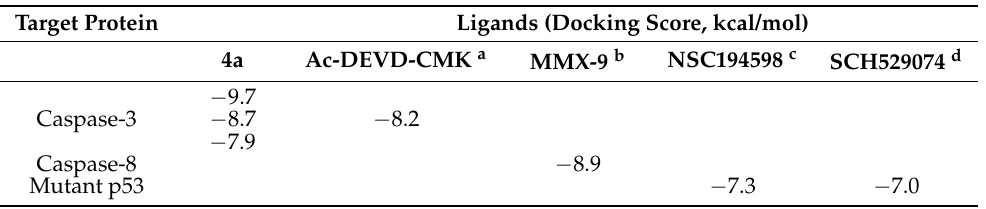
Table 2. The top-docking score (binding affinity, kcal/mol) of the hybrid 4a against multiples molecular